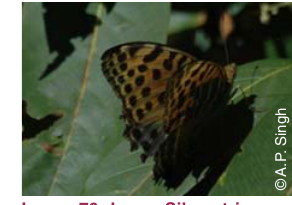
Image 68. Indian Red Admiral, Vanessa indica (upper)